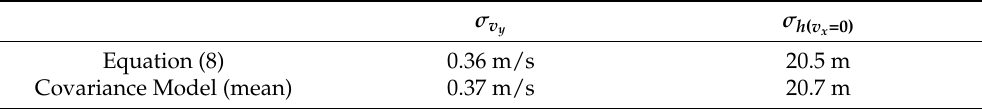
Table 5. Comparison between the simple model of Equation (8) and uncertainties derived from the retrieval covariance matrix shows good agreement. A 10 m geolocation error was assumed everywhere within the Hold F2 collection. The covariance model results have a very small dependence on XT position and height above the ellipsoid.